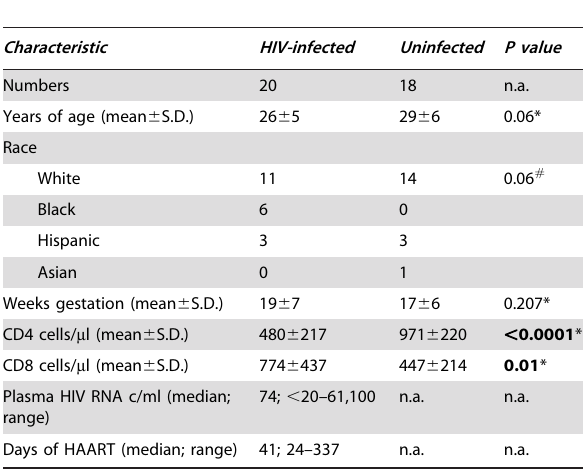
Table 1. Baseline Characteristics of Study